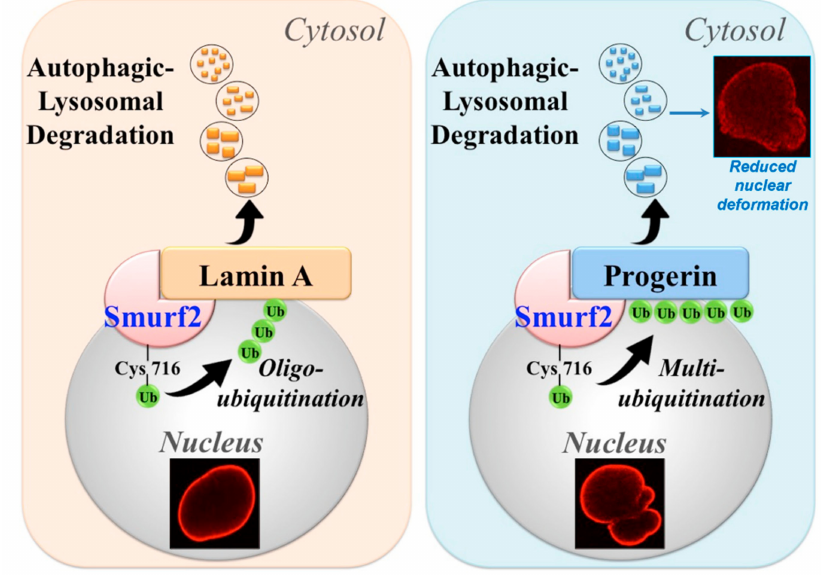
Figure 3. SMURF2 regulates stability and the autophagic-lysosomal turnover of lamin A and progerin. SMURF2 was shown to oligo-ubiquitinate lamin A and multi-monoubiquitinate progerin, targeting these proteins for degradation through autophagy. Cys716, the active-site cysteine of SMURF2. The confocal images presented in the figure are from